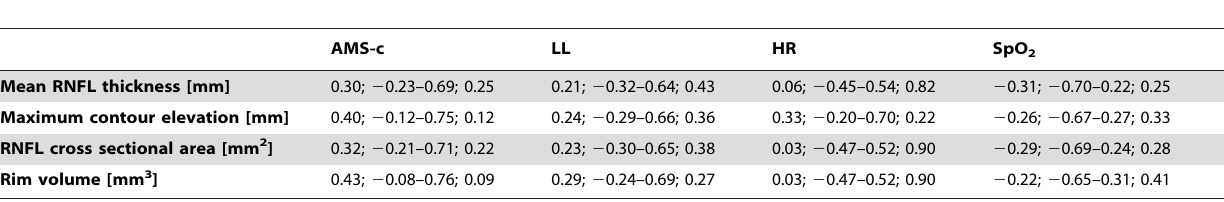
Table 4. Pearson’s correlation of key stereometric parameters with clinical scores of AMS on day2.